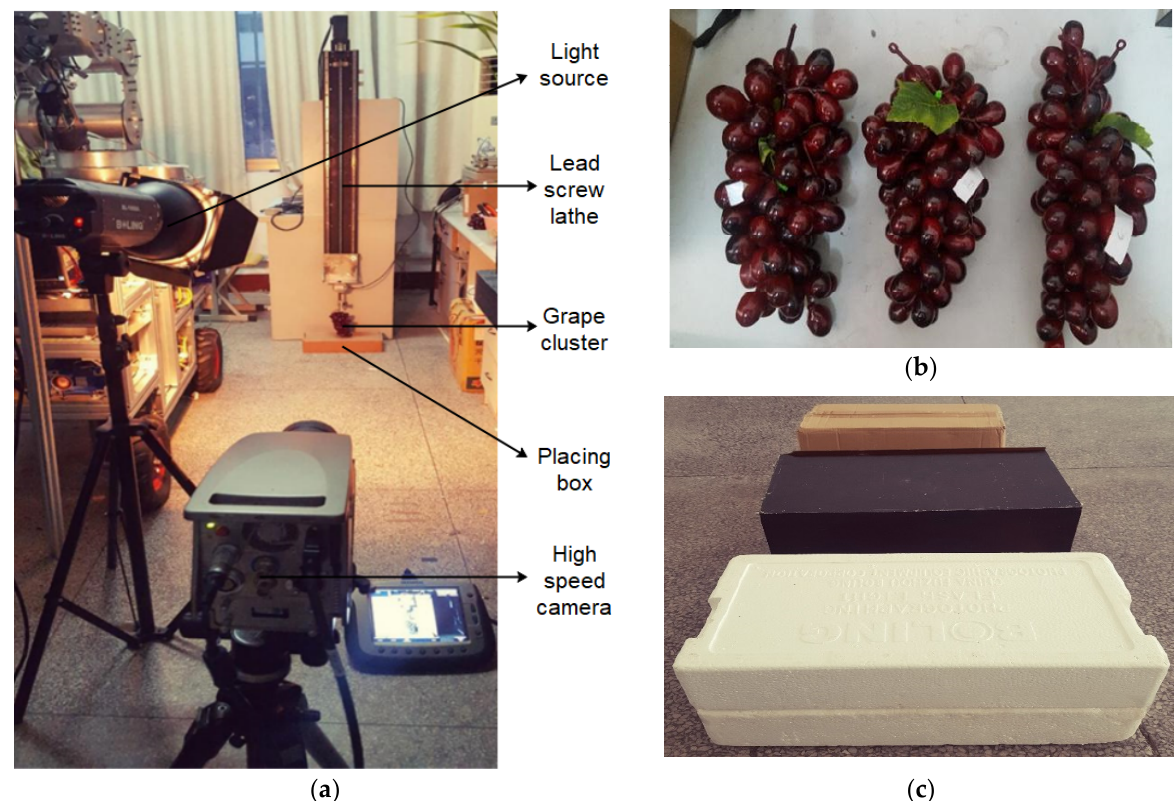
Figure 3. Experimental materials: ( a ) experimental setup; ( b ) 3-grape clusters; ( c ) 3-packaging materials.